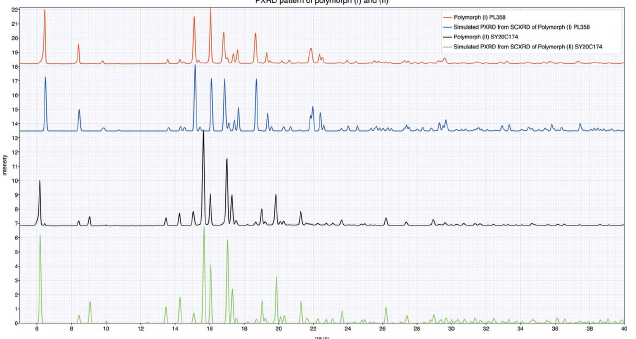
Figure 7 PXRD patterns of polymorphs ( I ) and ( II ) and their simulated patterns from the SCXRD study at room temperature.